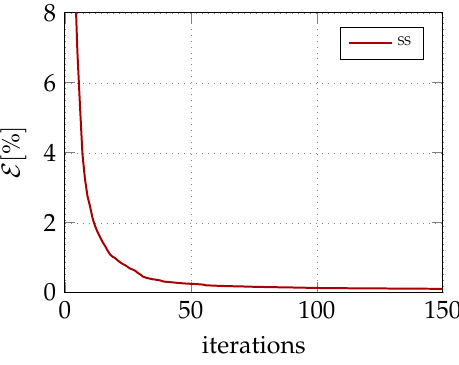
Figure 8. Convergence of the multi-start GCMMA for the optimisation problem of stage